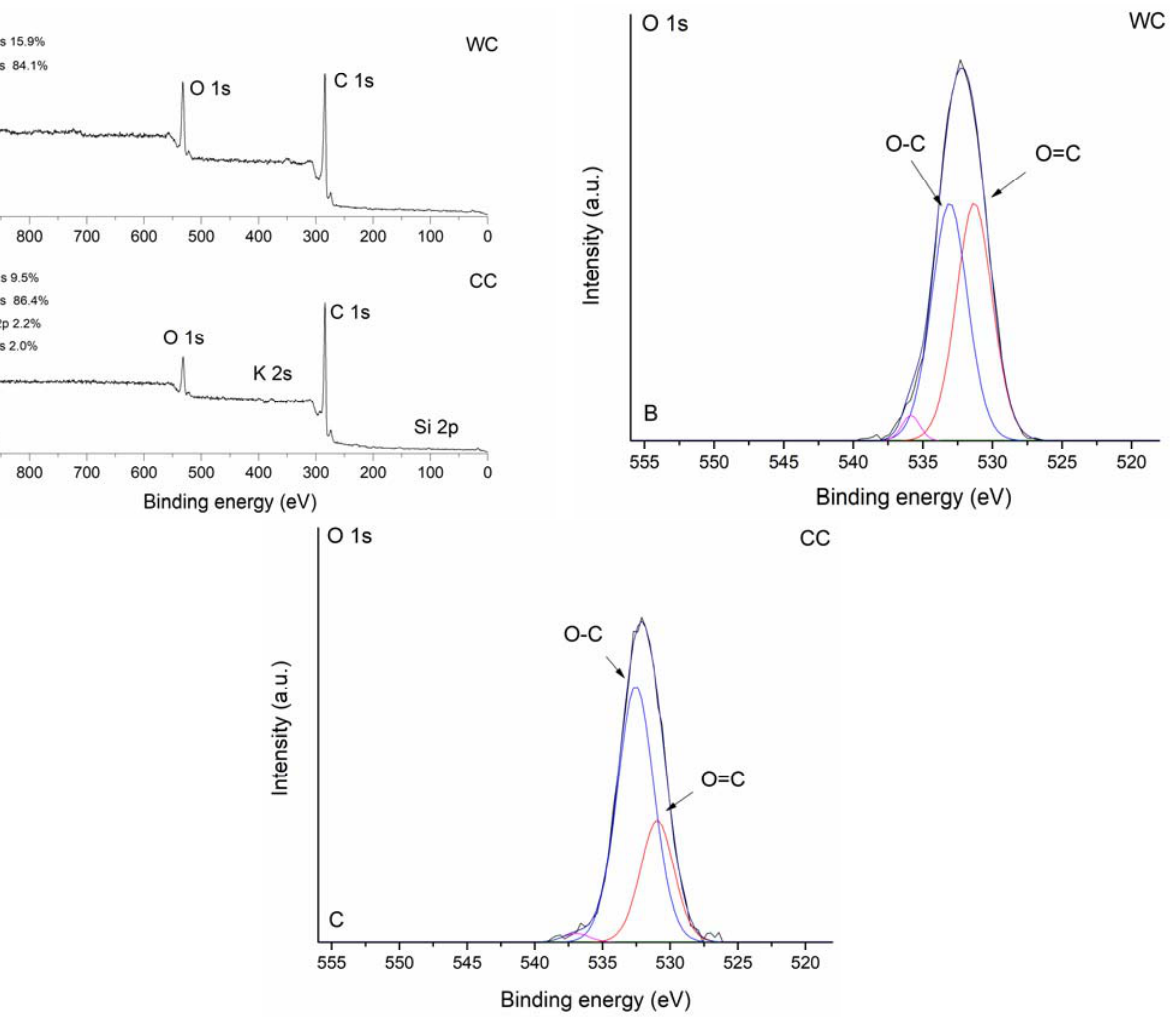
531.0 eV (CC) and 531.3 eV (WC) representing carbonyl oxygen; and (ii) peaks at 532.5 (CC) and 533.0 eV (WC) representing carbonyl oxygen in carboxylic and anhydrides, and O atoms in hydroxyl groups, which confirms the results found by FTIR. Moreover, it is evident that the intensity of the O ‐ C component relative to the O=C component for CC is greater than for the WC biochar. Peaks at high binding energies 535.8 and 536.9 eV could be attributed to adsorbed water [45].